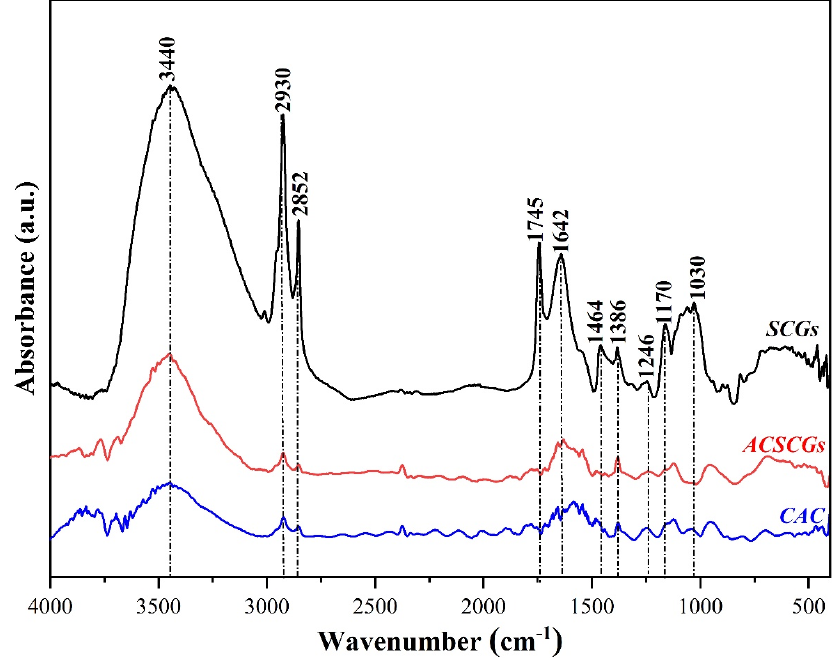
Figure 5. FTIR spectra of spent coffee grounds (SCGs), activated carbon of spent coffee grounds (ACSCGs), and a commercial activated carbon (CAC).